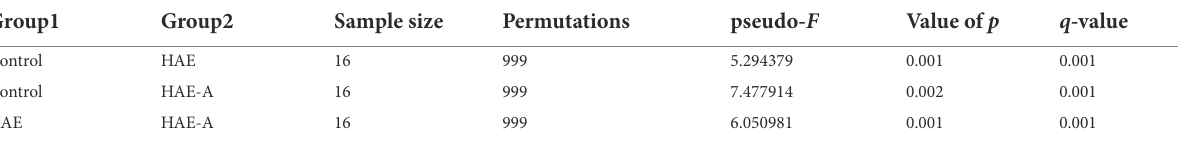
TABLE 2 PCoA diversity difference